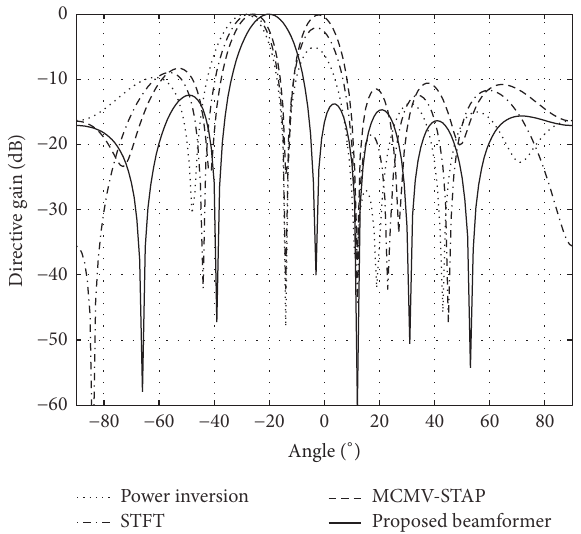
Figure 11: The array antenna pattern of antijamming for different method: the angle of arrival of the satellite signal is − 20 degrees and the angles of arrival of jamming signals are − 14 degrees and 12 degrees.